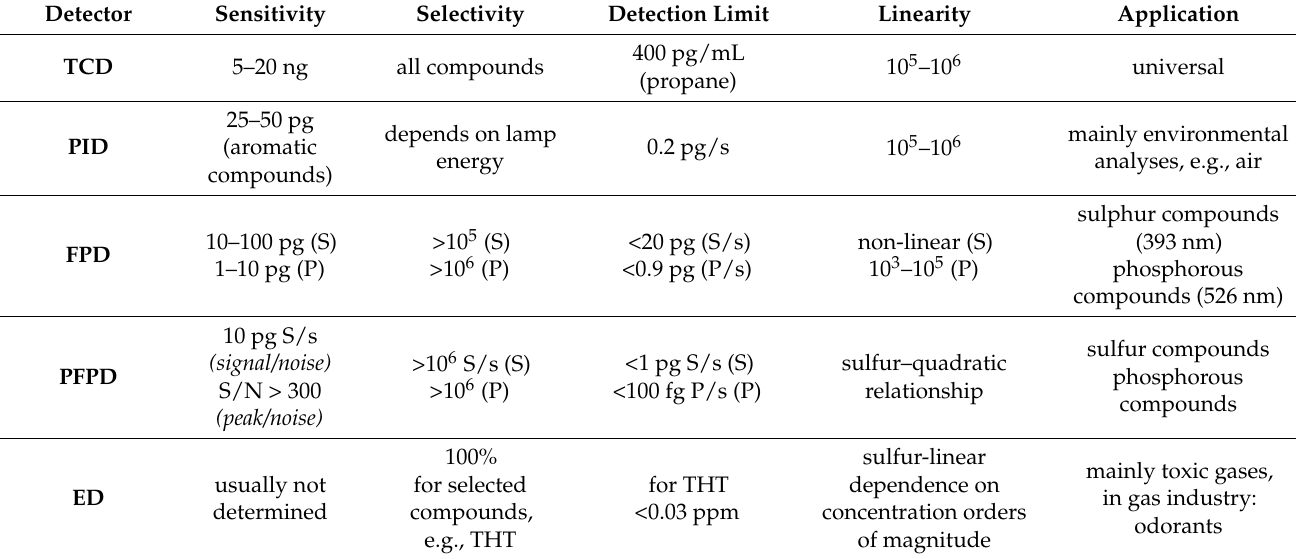
Table 1. Characteristics of detectors used in chromatographic analyses of sulfur compounds